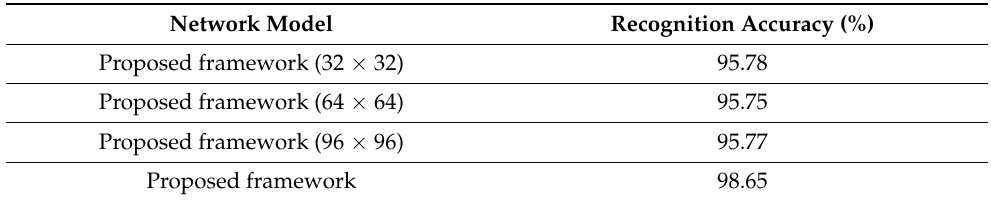
Table 3. Normalized hand gesture recognition rate of the proposed framework.